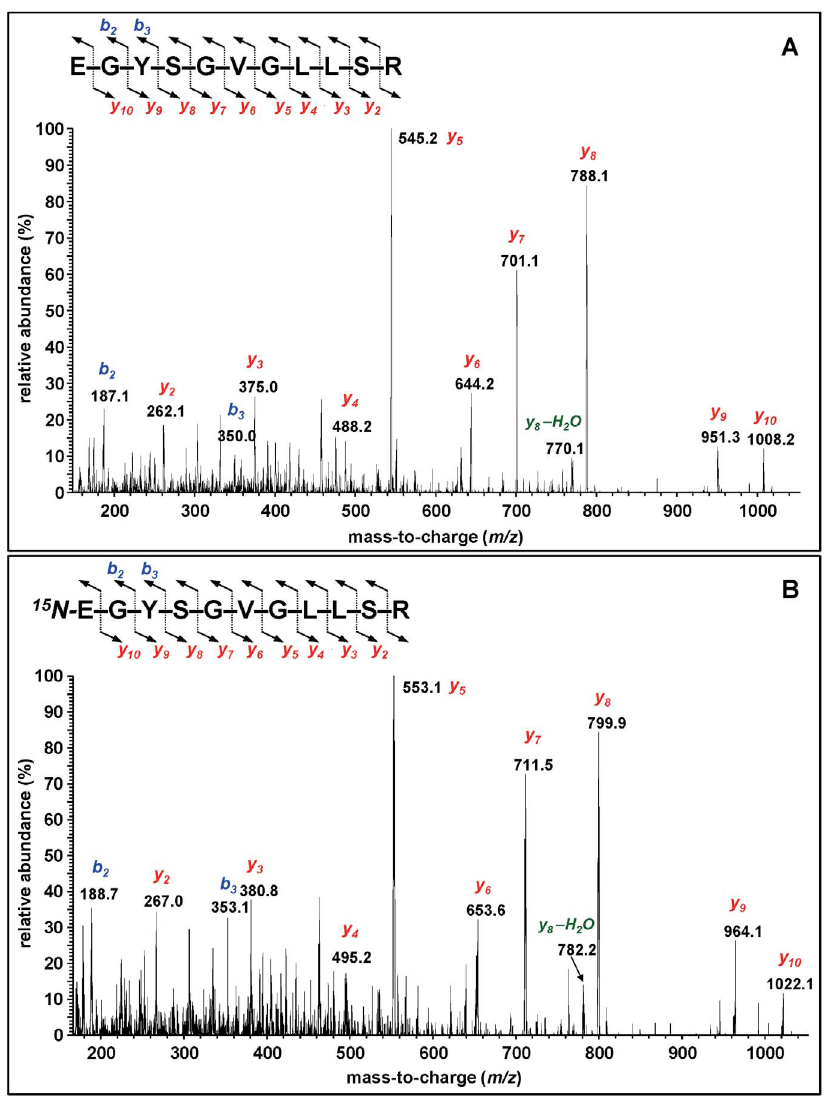
Figure 3. Product ion spectra of EGYSGVGLLSR (A) and 15 N-EGYSGVGLLSR (B). The (M + 2H) 2 + ions m/z 569.3 and m/z 576.3 (Table 1), respectively, were used as the precursor